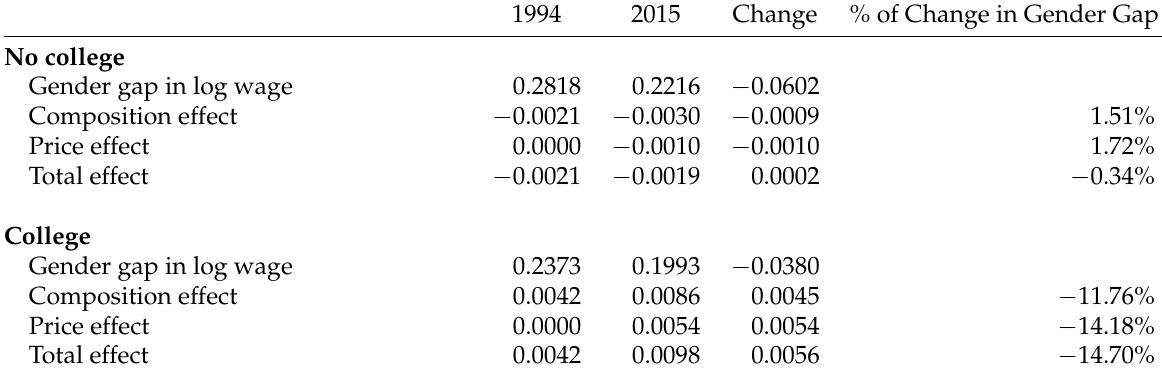
Table 4: Contributions of the composition and price effect of programming intensity to the convergence of the gender wage gap from 1994 to